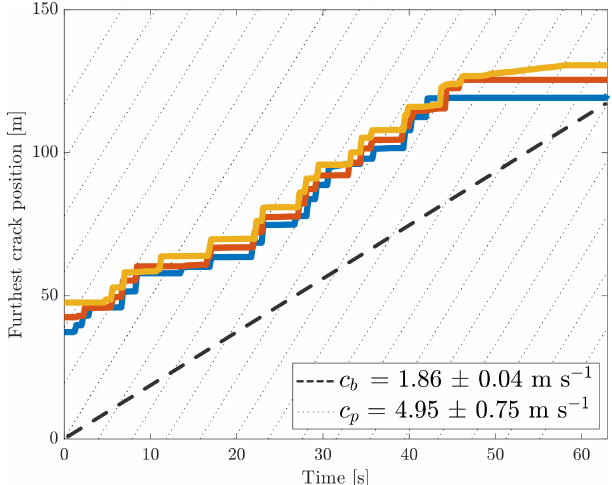
Figure 6. Temporal evolution of the furthest crack location relative to the floe edge at x = 0 along the three coloured polygons shown in Fig. 5. Dotted lines indicate the position of wave crests, and the slope of the bold dashed line is obtained from the linear